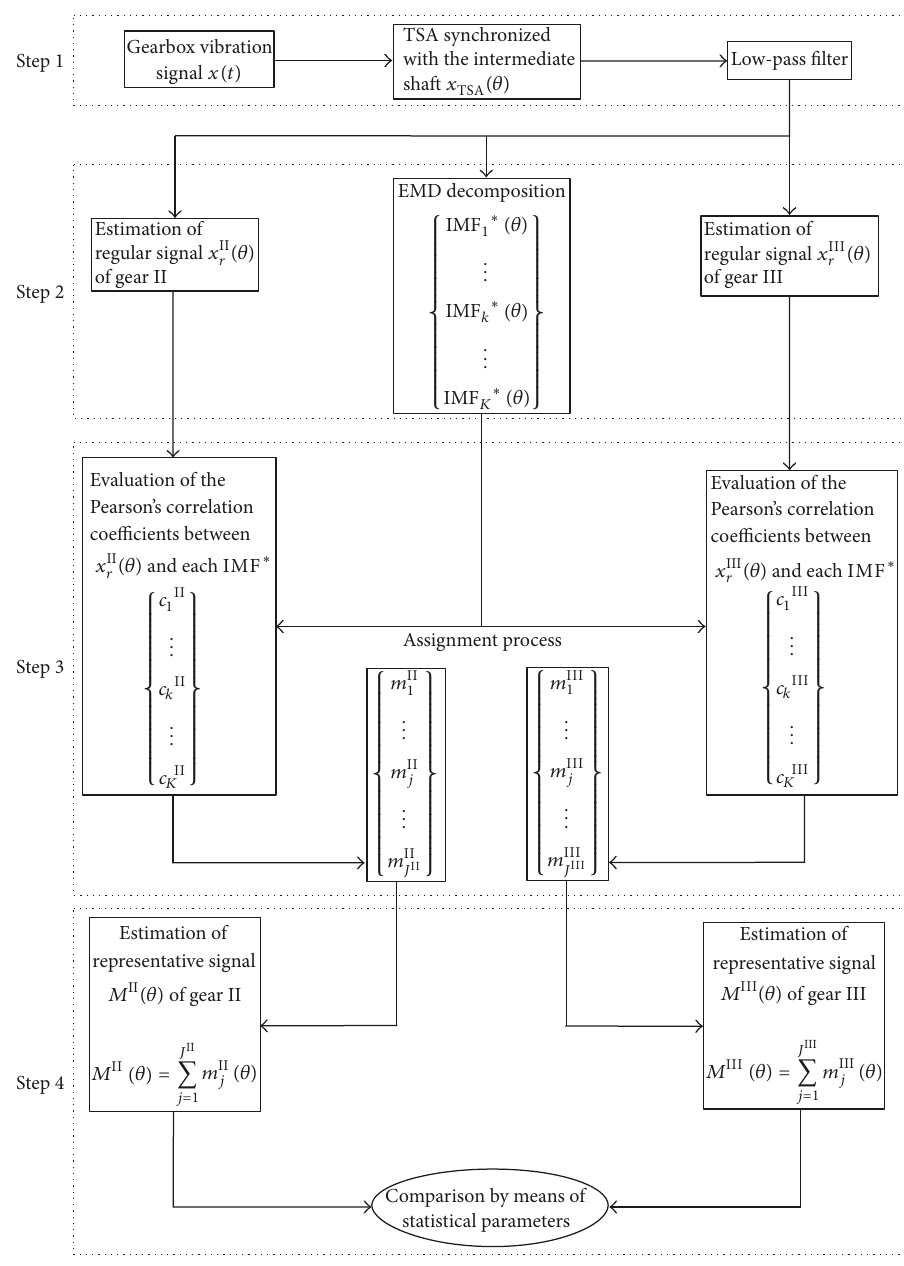
Figure 5: Flow-chart of the proposed